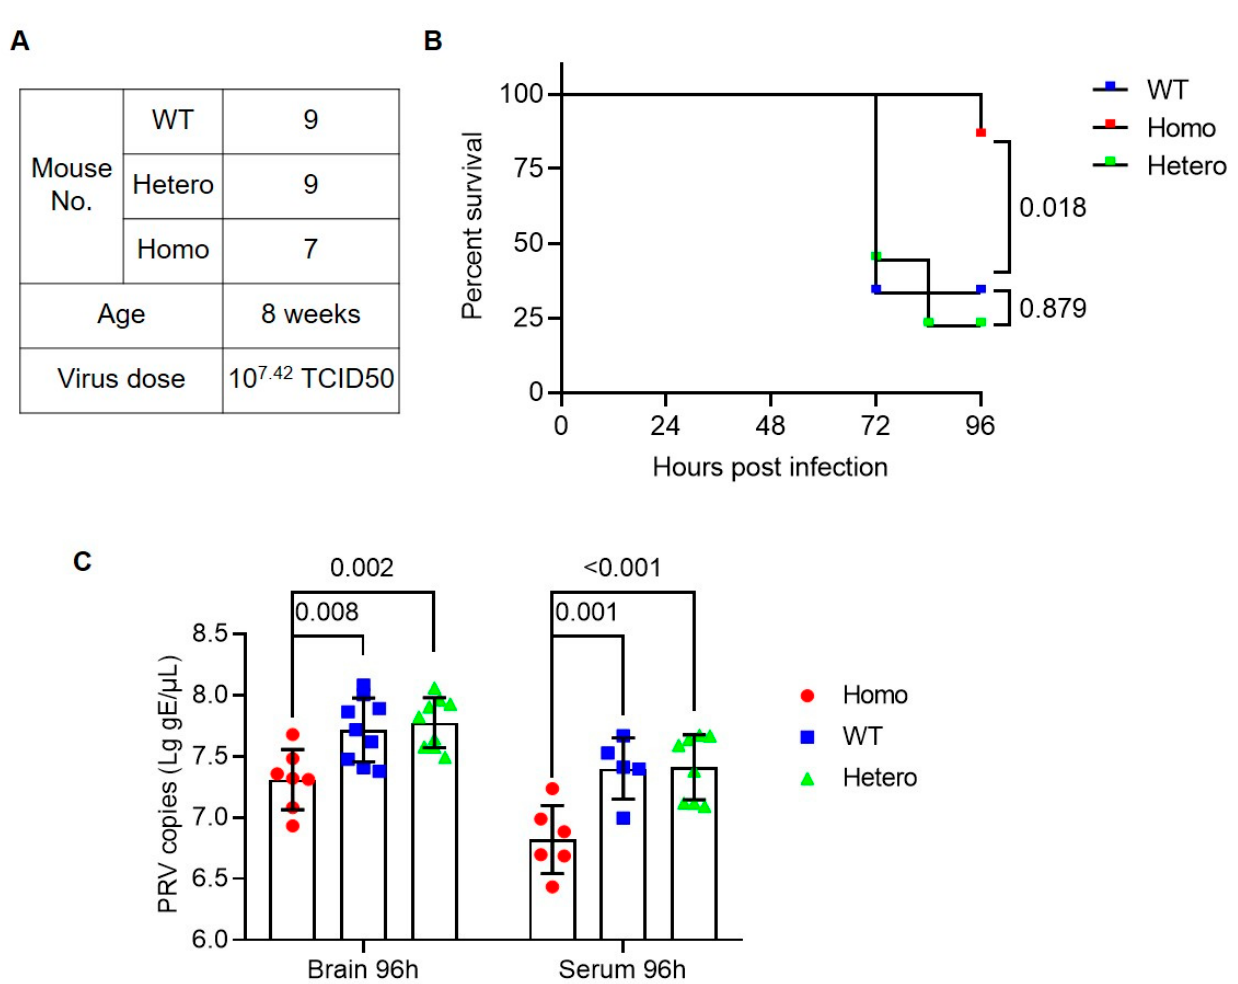
Figure 3. Viral challenge experiment 2 in nectin1 (F129A) mutant mice. ( A ) Experimental groups and virus dose for PRV challenge. ( B ) Survival curve for nectin1 (F129A) homozygous mutant, heterozygous mutant, and WT mice after PRV challenge within 96 h. ( C ) PRV viral loads in brain and serum by qPCR quantification of PRV gE gene. All surviving mice were sacrificed to analyze viral load in brains and serum at 96 h after viral challenge. Data are presented in mean ± standard deviation. Statistically significant differences are indicated by p -values, analyzed with Gehan–Breslow–Wilcoxon test and two-way ANOVA for survival curve and viral copies, respectively. Homo, homozygous nectin1 (F129A) mutant mice; Hetero, heterozygous nectin1 (F129A) mutant mice; WT, wild-type mice.